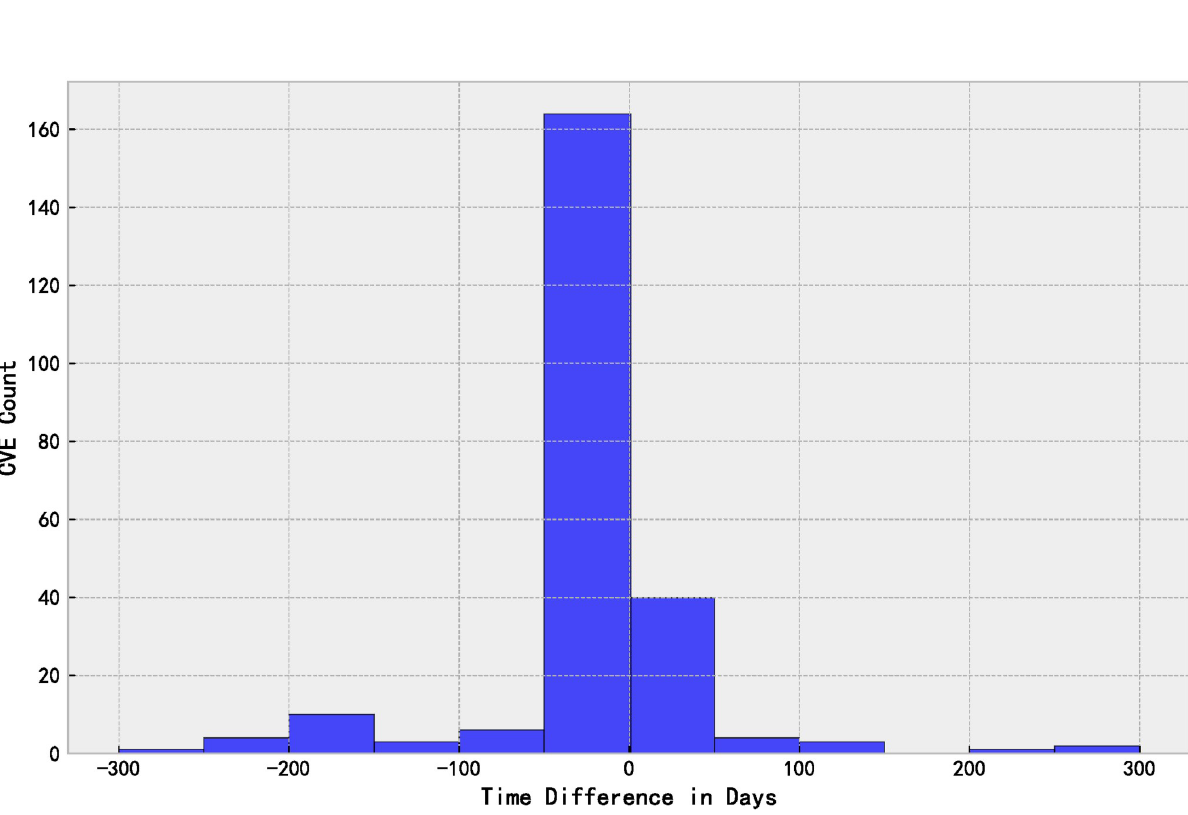
PLOS ONE | https://doi.org/10.1371/journal.pone.0228439 February 6,